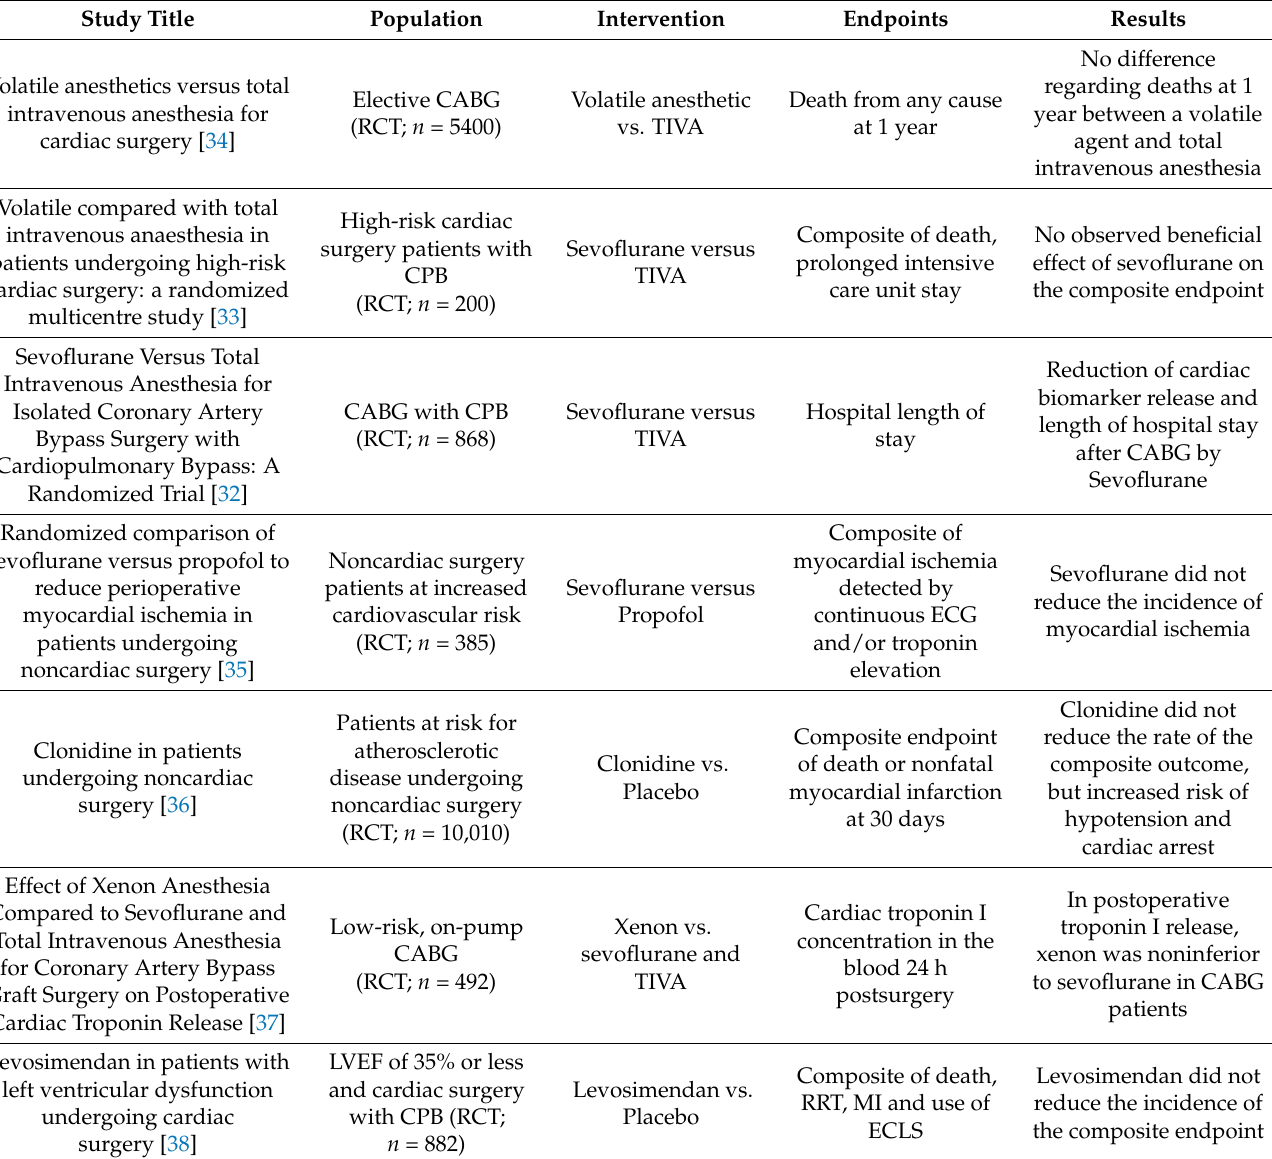
Table 1. Important clinical trials on pharmacological